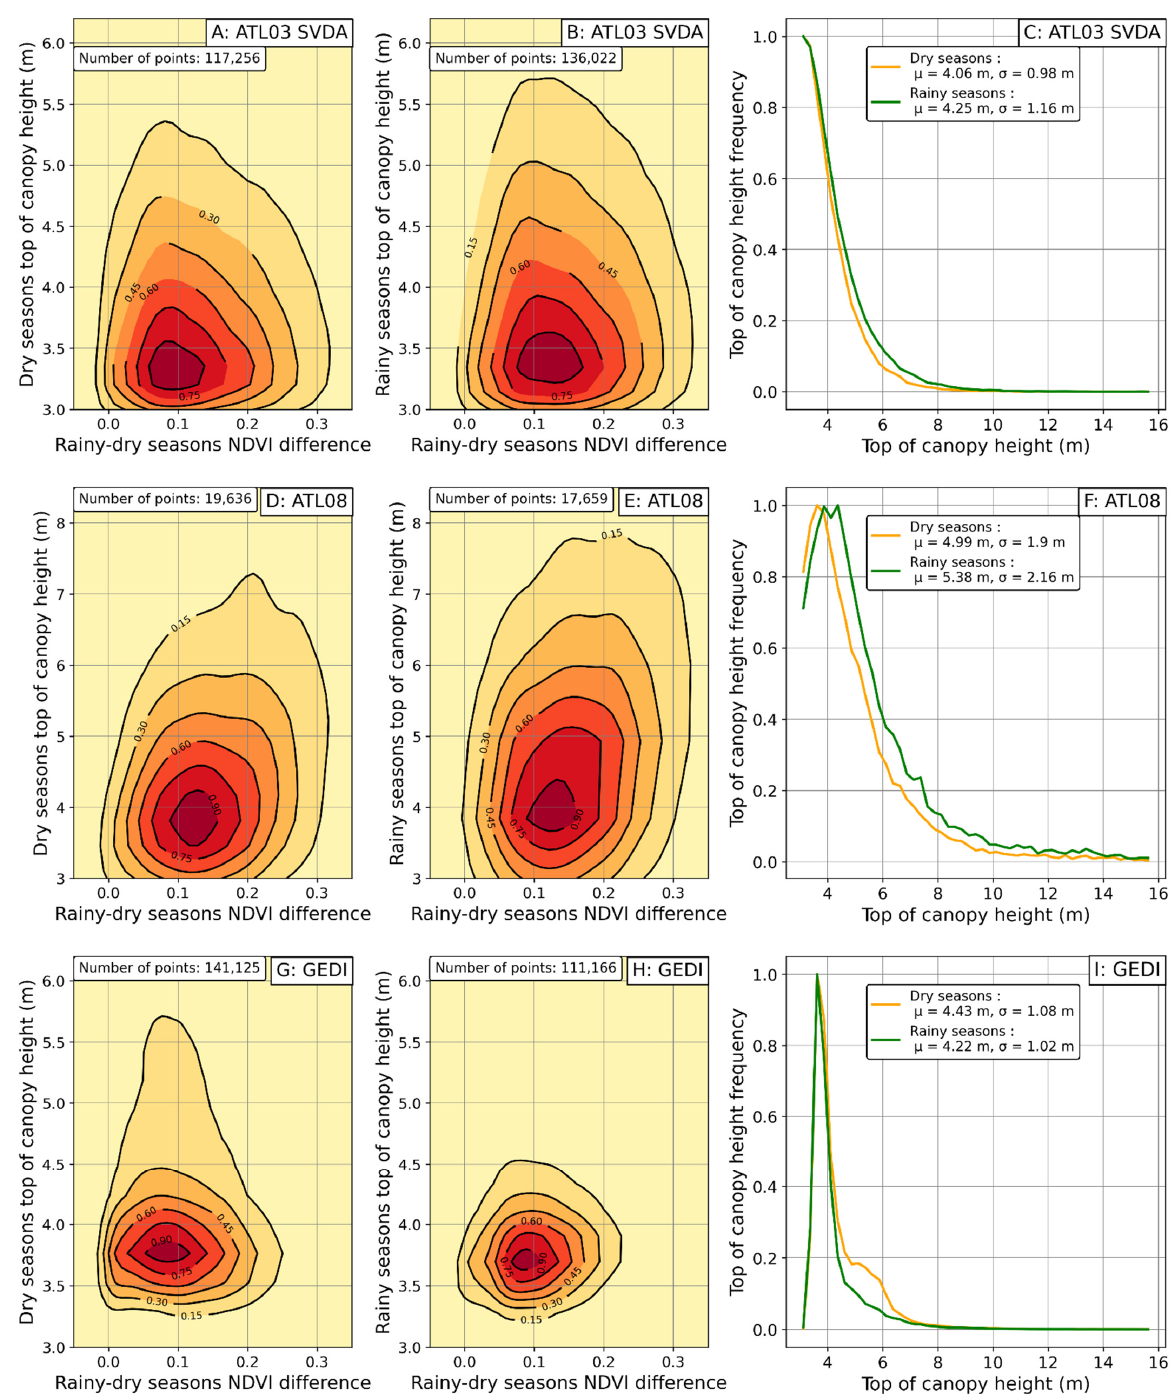
height differences for vegetation heights above 3 m for the inter-seasonal comparison for ATL03 SVDA, ATL08, and GEDI data show p values below 0.05.